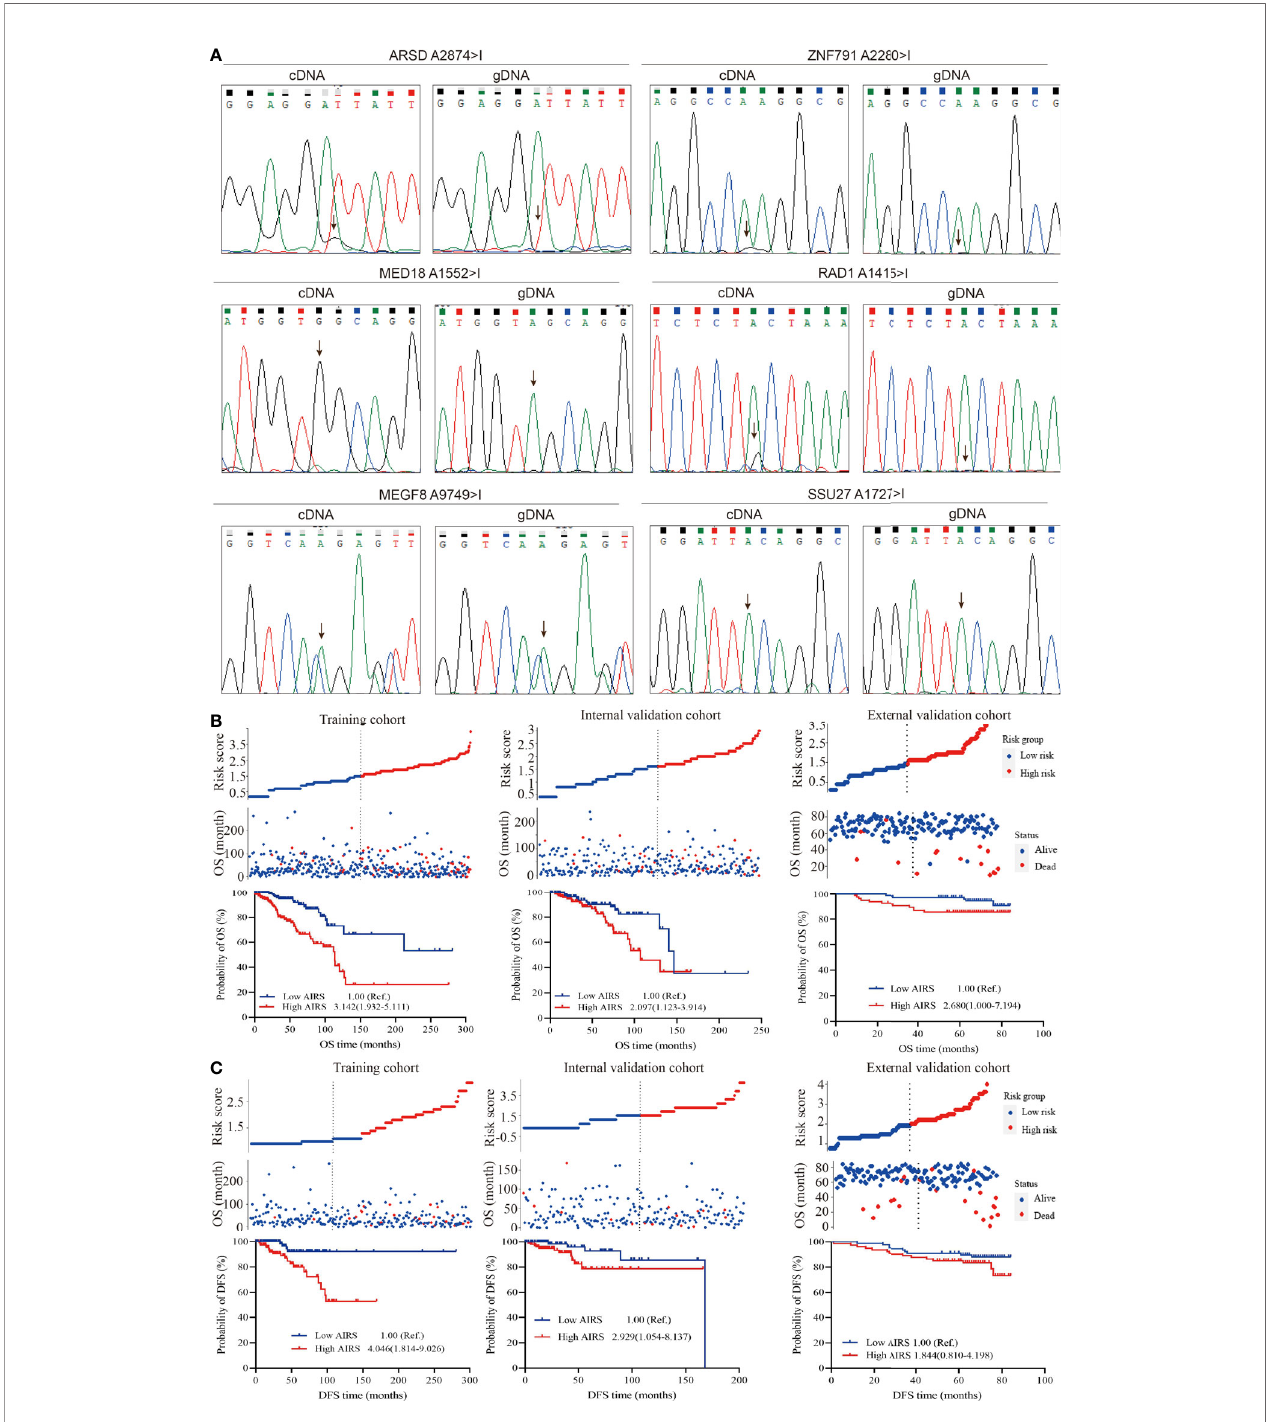
FIGURE 3 | Correlation between AIRS, OS, and DFS of BRCA patients. (A) Validation of the selected ATIRE sites by direct sequencing. cDNA, complementary DNA; gDNA, genomic DNA. (B) Distribution of the risk score (top), survival status (middle), and Kaplan – Meier plot (bottom) to visualize the OS probabilities for AIRS in the training cohort (left), internal validation cohort (middle), and external validation cohort (right). (C) Distribution of the risk score (top), survival status (middle), and Kaplan – Meier plot (bottom) to visualize the DFS probabilities for AIRS in the training cohort (left), internal validation cohort (middle), and external validation cohort (right). Hazard ratio (HR) values were calculated by the Cox regression model, as shown in the Kaplan – Meier plot. AIRS, adenosine-to-inosine RNA editing-based risk score; OS, overall survival; DFS, disease-free survival; BRCA, breast cancer; ATIRE, adenosine-to-inosine RNA